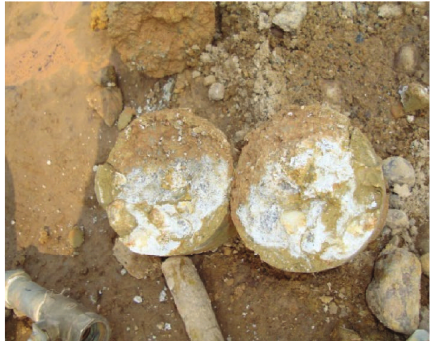
Figure 15: Core sample of fine gravel after grouting.